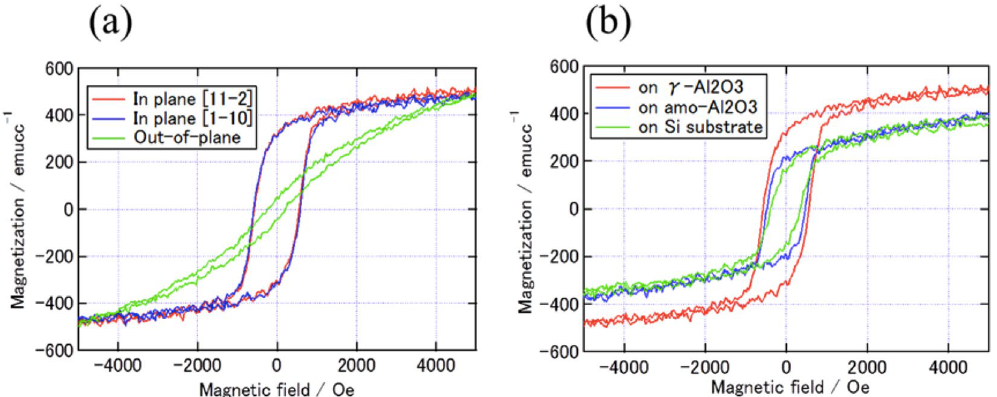
Figure 6. Magnetic properties ( a ) Magnetization curves of Fe 3 O 4 on γ -Al 2 O 3 in the magnetic field along [11-2], [1-10], and out of plane [111] ( b ) Magnetization curves of EPI, AMO, and W/O in the magnetic field along